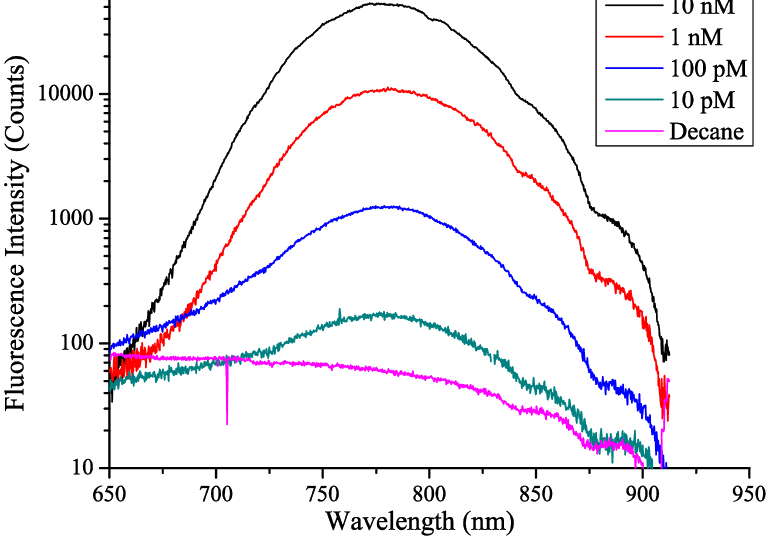
Figure 5. In-fiber fluorescence measurements with varied Qdot concentrations. As